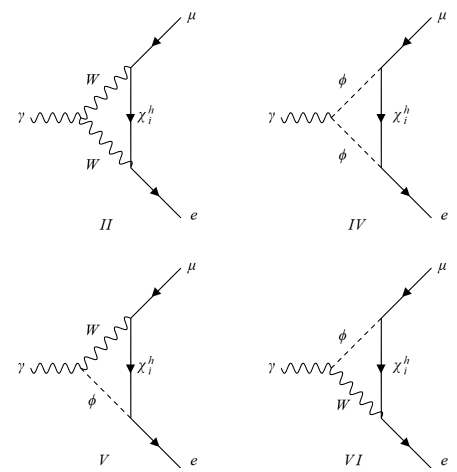
Figure 3 . Feynman diagrams involved in the µ → eγ decay considering heavy neutrinos. We have to take into account the self-energy diagrams, additionally. φ are the would-be Goldstones absorbed by W boson in the unitary gauge.